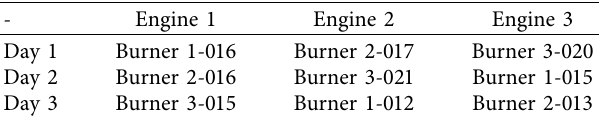
Figure 13: Fourth regular graph. Table 5: Burners, engines, and days.